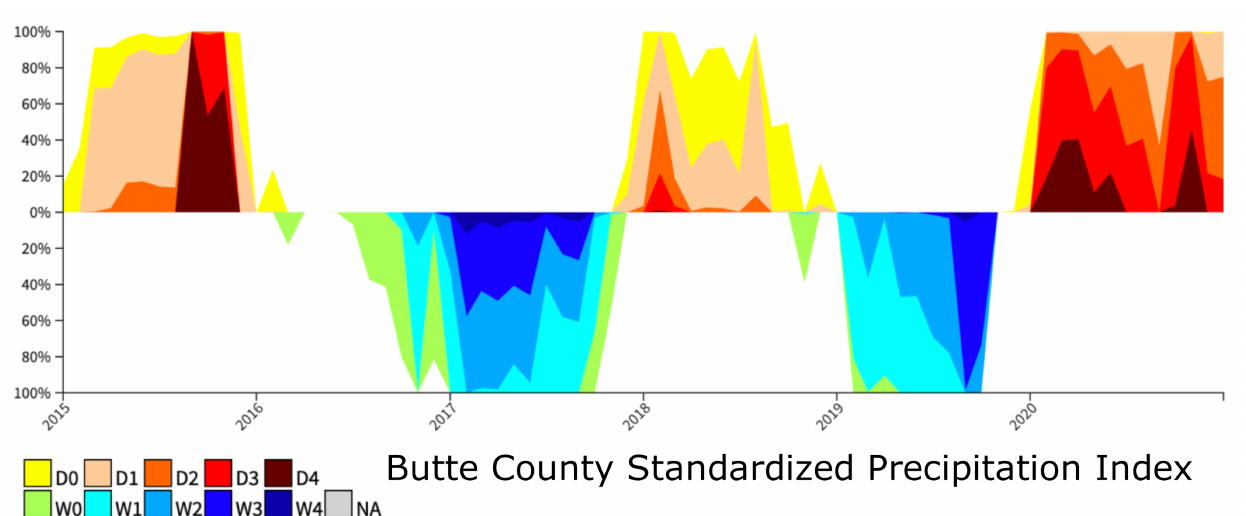
Figure 2. Monthly standardized precipitation index (SPI) from the National Integrated Drought Information System for Butte County, CA. Prefixes D and W denote dry and wet; indices 0–4 correspond to abnormal, moderate, severe, extreme, and exceptional wet and dry